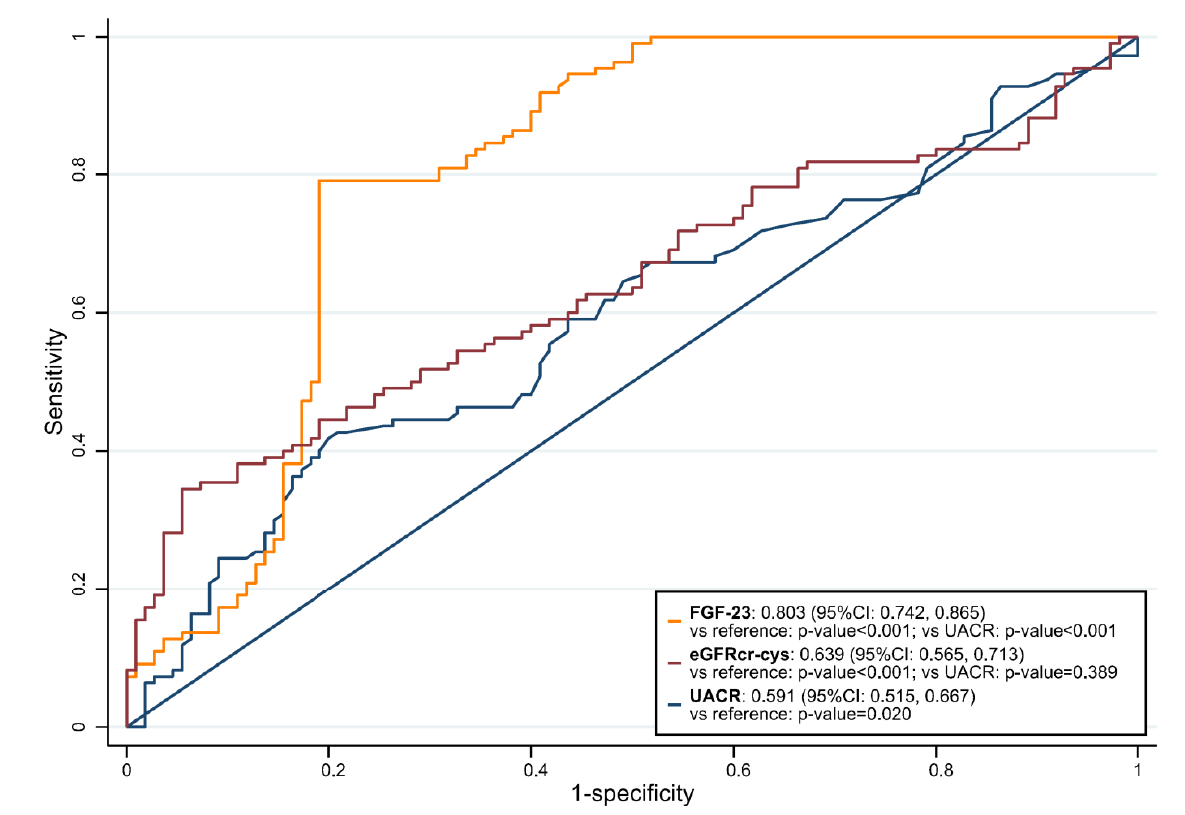
Figure 3. The areas under the receiver operating characteristic (AUROC) curve for biomarkers to predict the occurrence of 5-year RKFD.